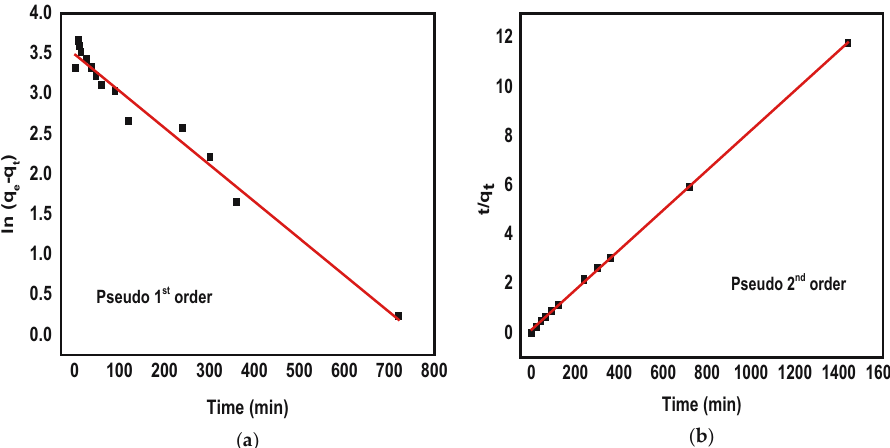
Figure 5: The fi tting of experimental data to pseudo - fi rst - order model ( a ) and pseudo - second - order model ( b ) for the adsorption of Cr ( VI ) ions on the surface of PDA/NC